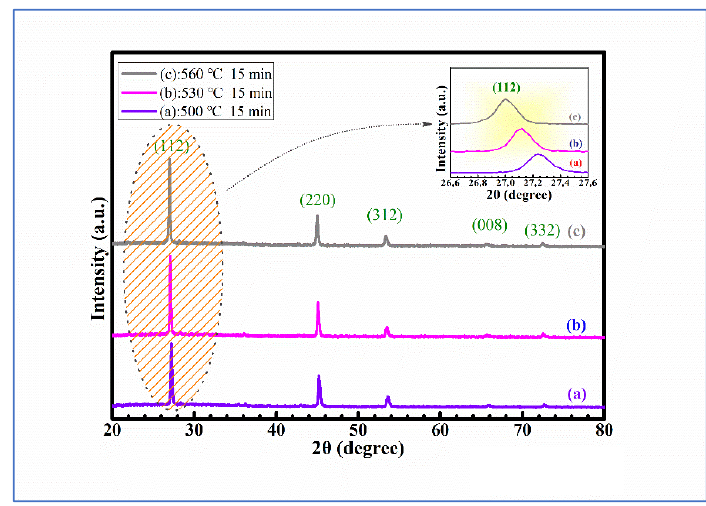
Figure 1. XRD spectra of Cu 2 Mg 0.2 Zn 0.8 Sn(S,Se) 4 (CMZTSSe) films annealed at different temperatures ( a ) 500 °C, ( b ) 530 °C, ( c ) 560 °C. Inset: Enlarged view of the corresponding (112) diffraction peak of the CMZTSSe films annealed at different temperatures.